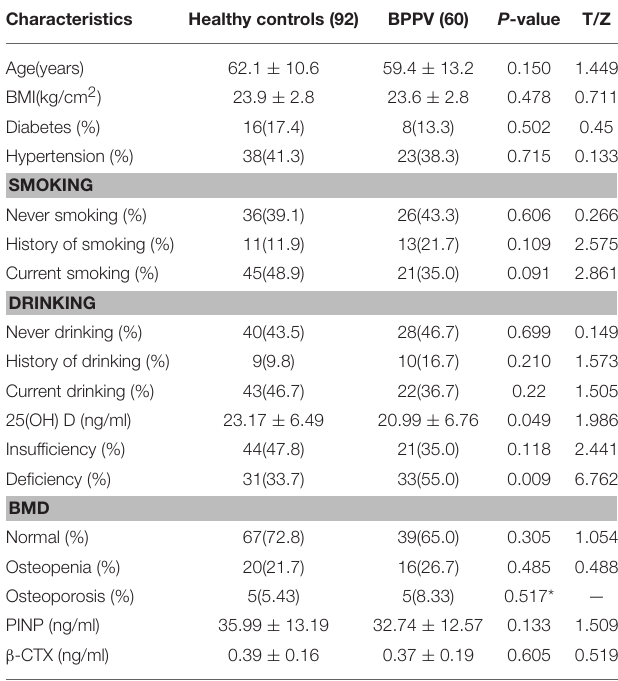
TABLE 1 | Clinical characteristics of benign paroxysmal positional vertigo patients and